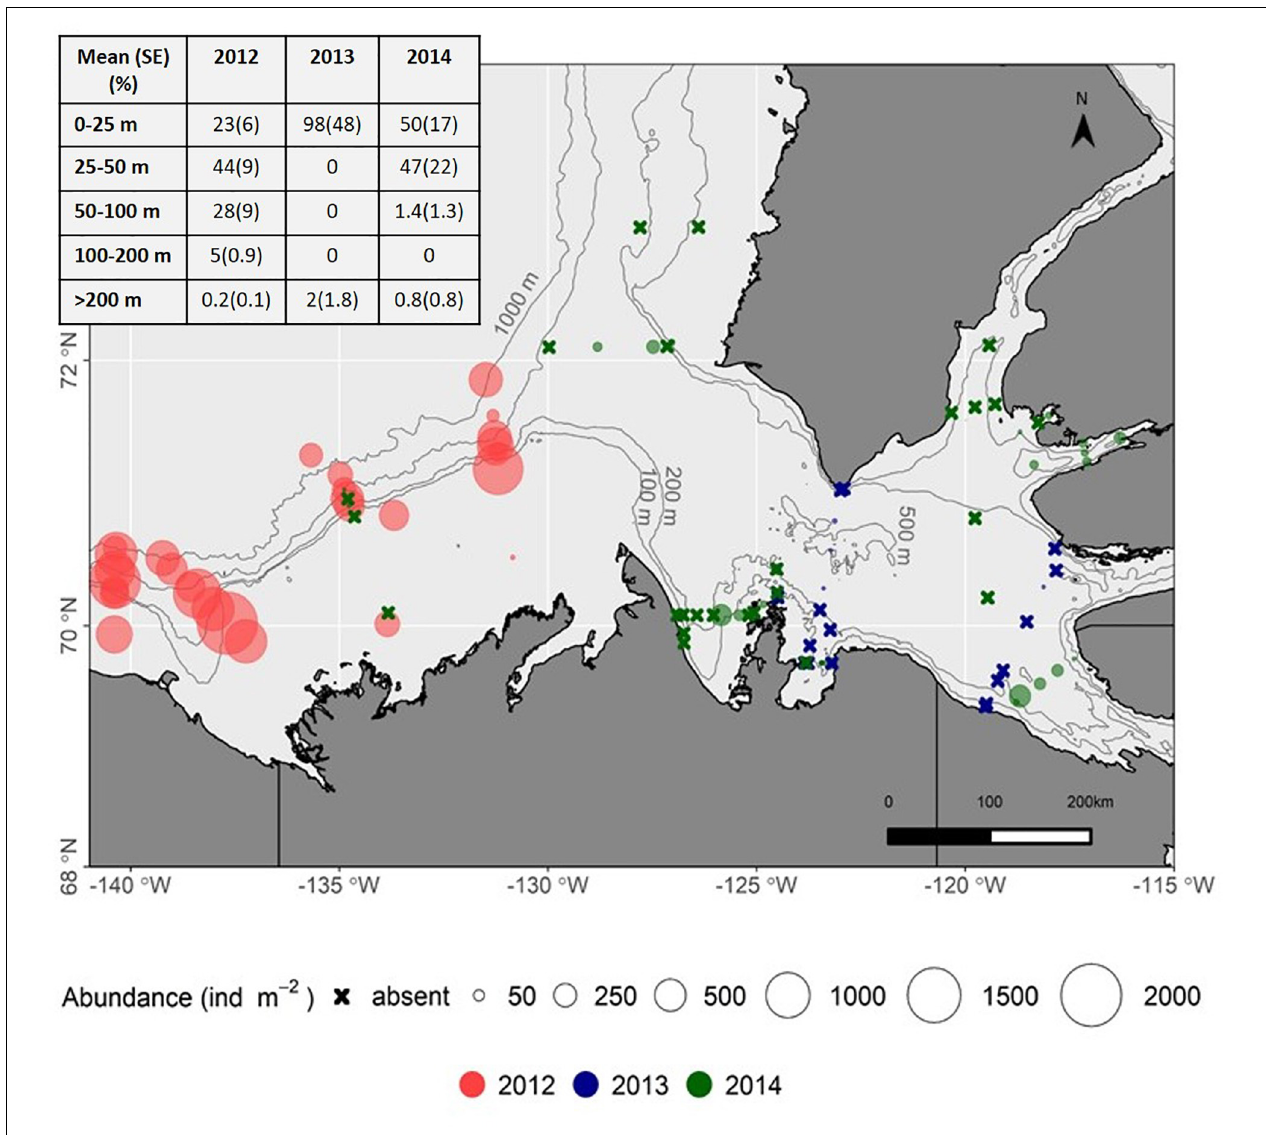
FIGURE 4 | Distribution of Limacina helicina on the Beaufort shelf and in the Amundsen Gulf, 2012–2014 (sampling depth integrated abundance indicated by circles, Ind m − 2 ). Inset table shows the distribution (%) of Limacina helicina present in sampled depth strata, all stations combined within a year.